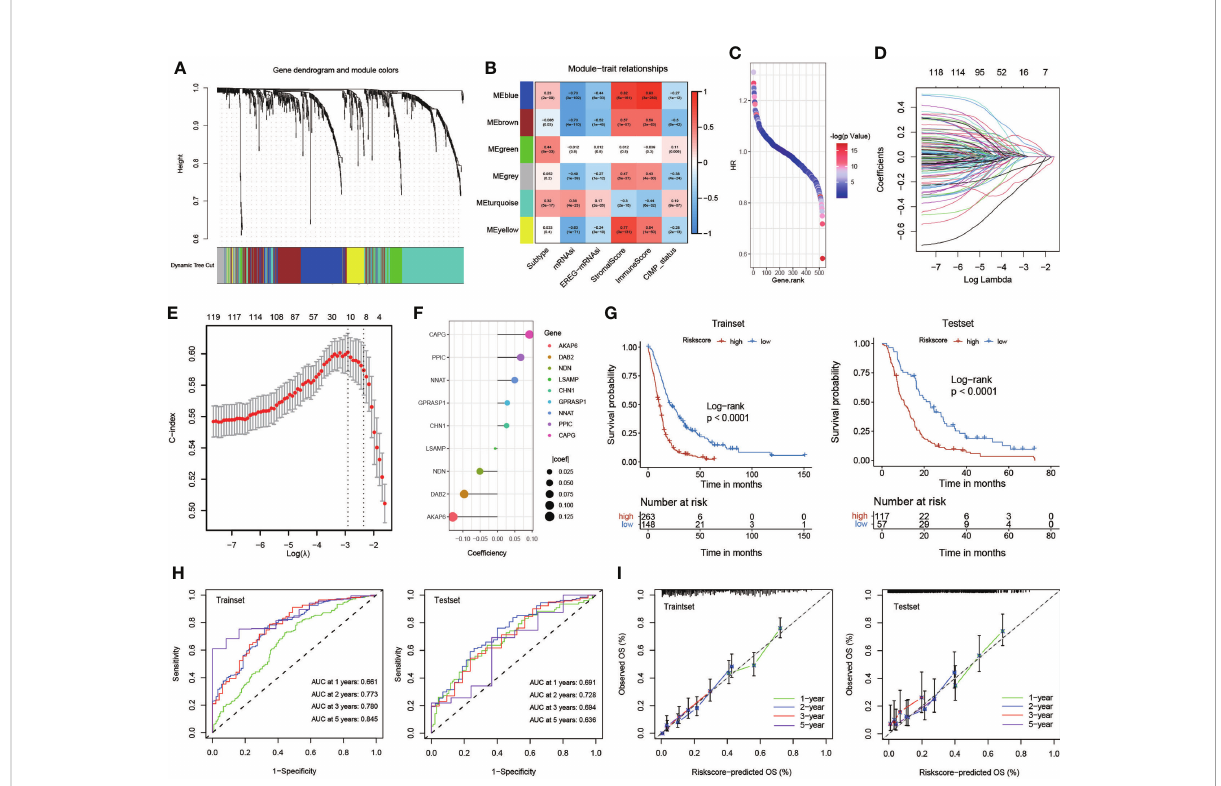
FIGURE 4 Construction and validation of the risk score. (A) Weighted gene coexpression network analysis (WGCNA) based on gene expression data identi fi ed gene modules with highly synergistic changes. (B) The heatmap of module-trait relationships. (C) Univariate Cox regression analysis of 524 genes relevant to GBM prognosis. (D, E) The least absolute shrinkage and selection operator (LASSO) method of anoikis-related genes associated with prognosis. (F) The risk score for predicting the survival and prognosis of patients with GBM. (G) Kaplan – Meier curves of the train set (p< 0.001, log-rank test) and test set (p< 0.001, log-rank test). (H) Time-dependent receiver operating characteristics (ROC) of the train set and the test set. (I) Calibration curves for risk score model in the train set and the test